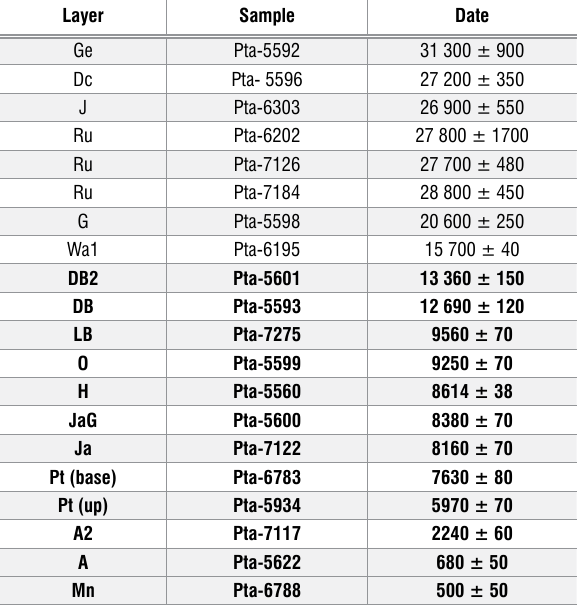
Uncalibrated radiocarbon dates from Rose Cottage Cave (from Wadley 17 ). The dates in bold belong to the layers sampled for palaeomagnetic research.